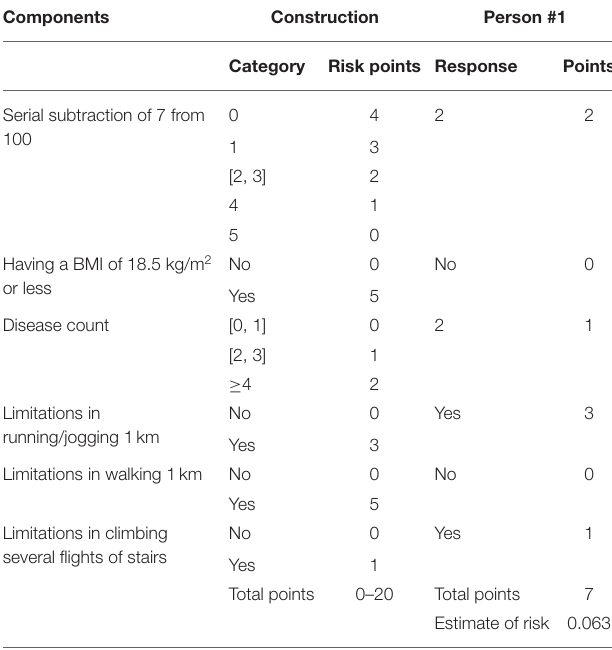
TABLE 1 | Components of the new simple functional score in